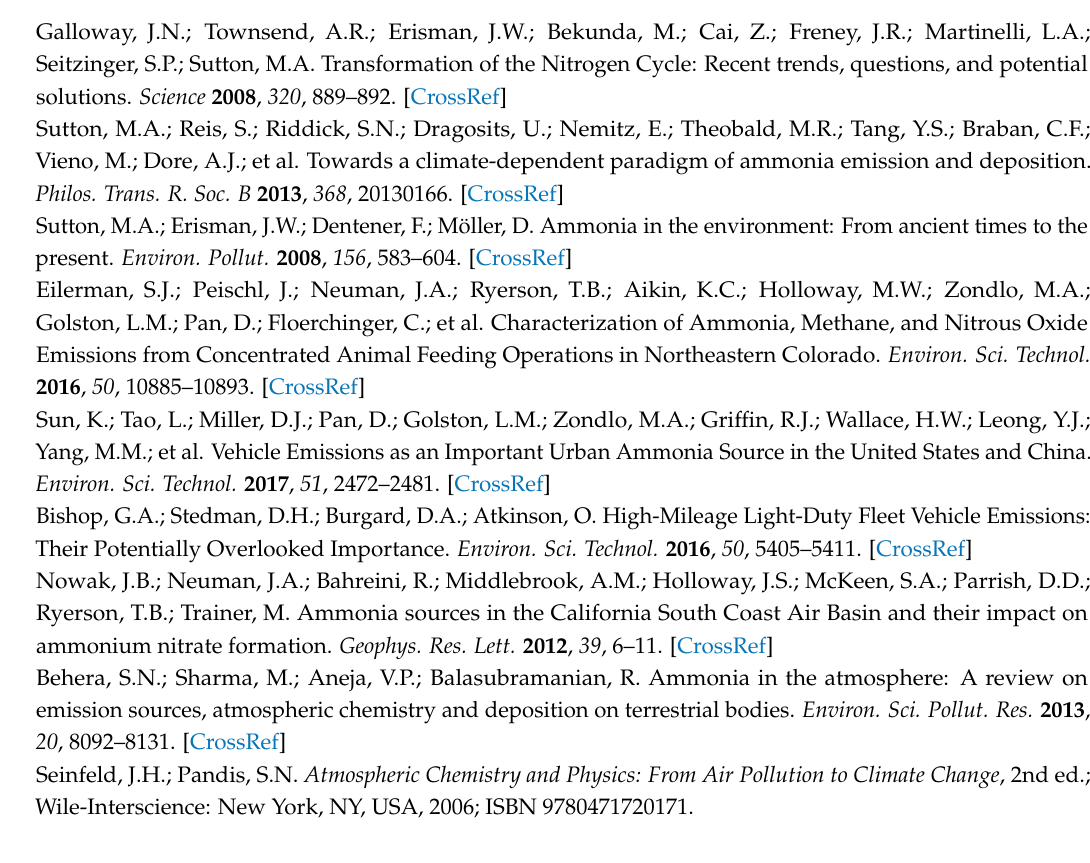
Figure S1. Ambient concentrations of trace gases (HCl, SO 2 , HNO 3 , and NH 3 ) and average PM 2.5 composition (pCl,